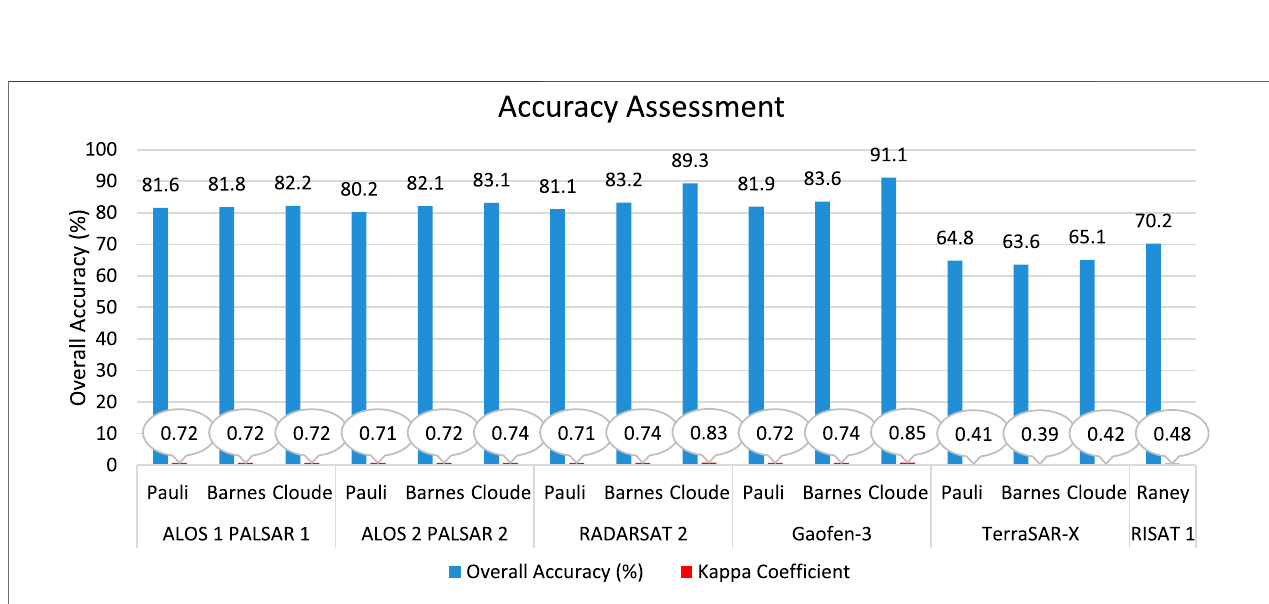
FIGURE 11 | Overall accuracy, kappa coef fi cient ( k c ), of LULC images obtained from Pauli, Barnes, Cloude, and Raney decomposition models using multifrequency and multi-temporal datasets.